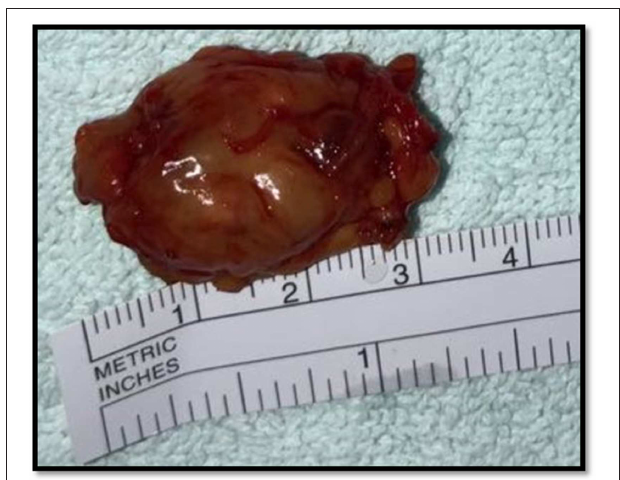
FIGURE 2 | Right supraclavicular adenopathy. A specimen of the right supraclavicular adenopathy by percutaneous biopsy.